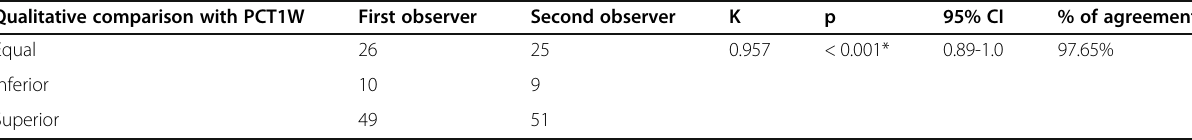
Table 2 Inter-observer agreement of qualitative comparison with PCT1 Qualitative comparison with